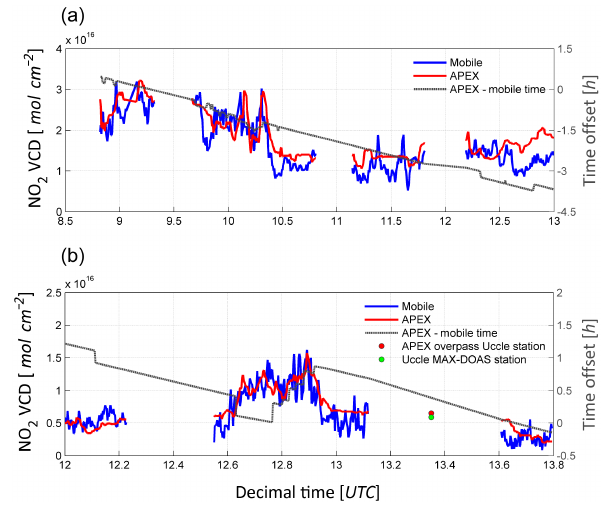
Figure 20. APEX and mobile-DOAS NO 2 VCD time series for (a) the Antwerp flight (day 105) and (b) the Brussels flight (day 181), respectively. The time offset between APEX and mobile- DOAS observations is plotted in dark grey. The NO 2 VCDs, mea- sured by APEX (red dot) and the mini MAX-DOAS (green dot) at the overpass over the Uccle station (13:21UTC) are indicated on Fig.